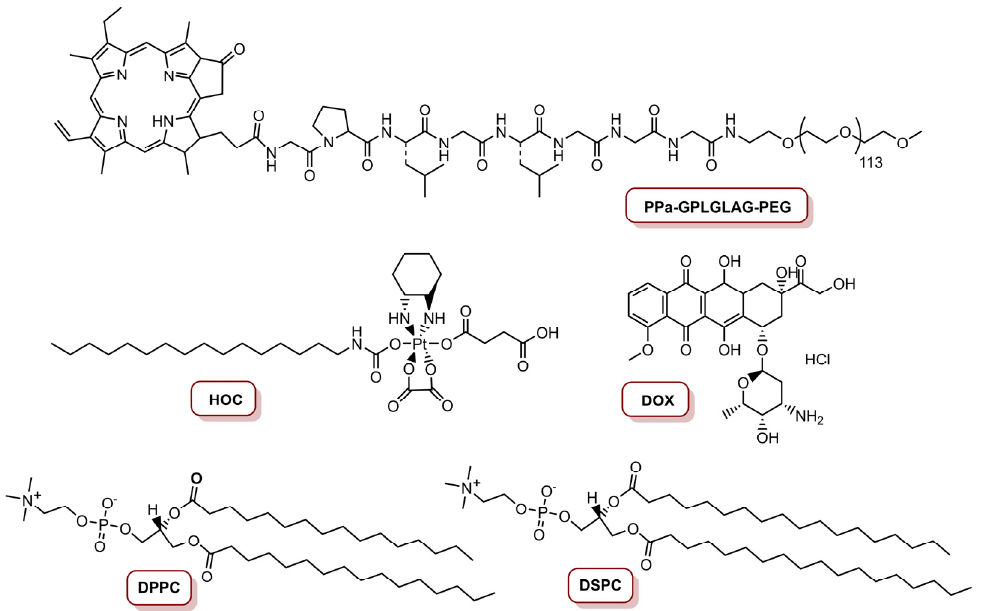
Figure 6. Structures of PPa-GPLGLAG-PEG, HOC prodrug, DOX and the DPPC and DSPC phospholipids used to prepare liposomal vesicles.